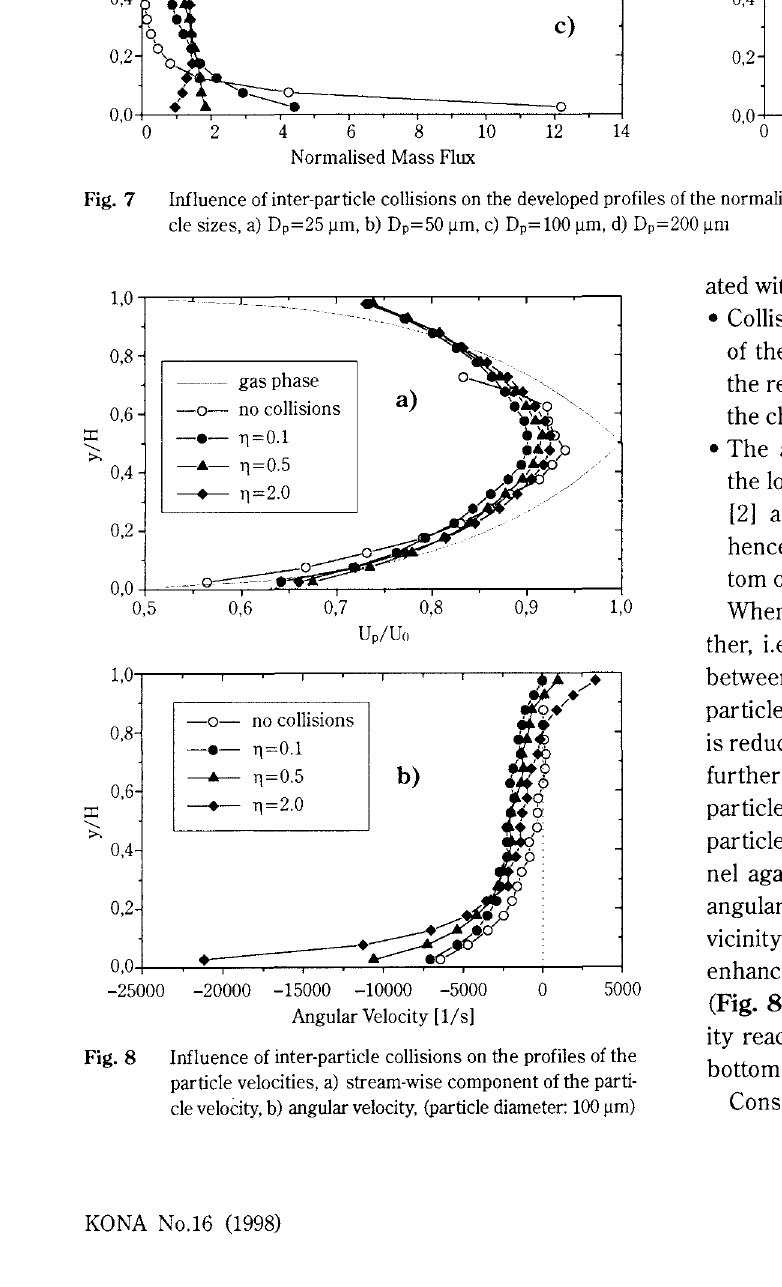
cle velocity, b) angular velocity, (particle diameter: 100